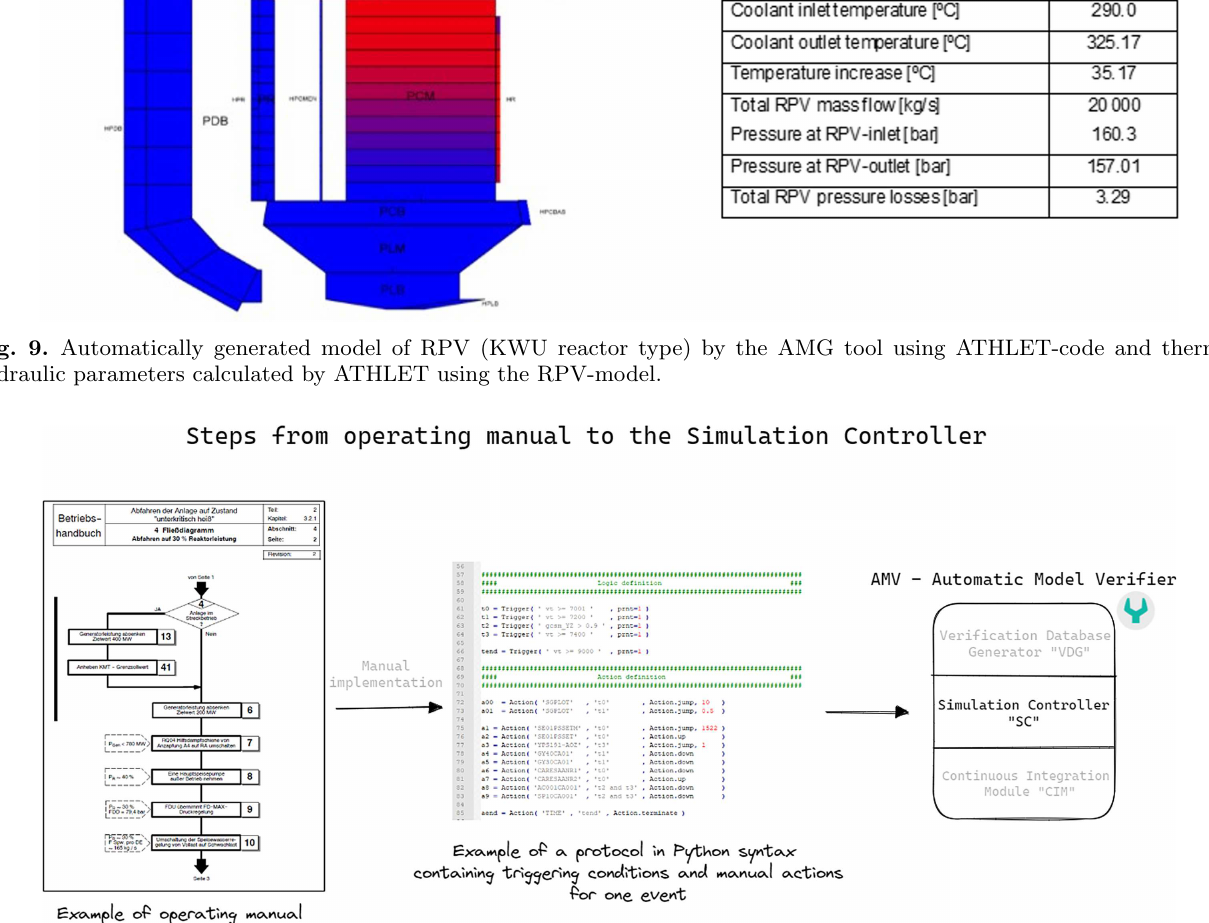
Fig. 10. Logging and implementation of manual actions in a protocol file for the automatic simulation